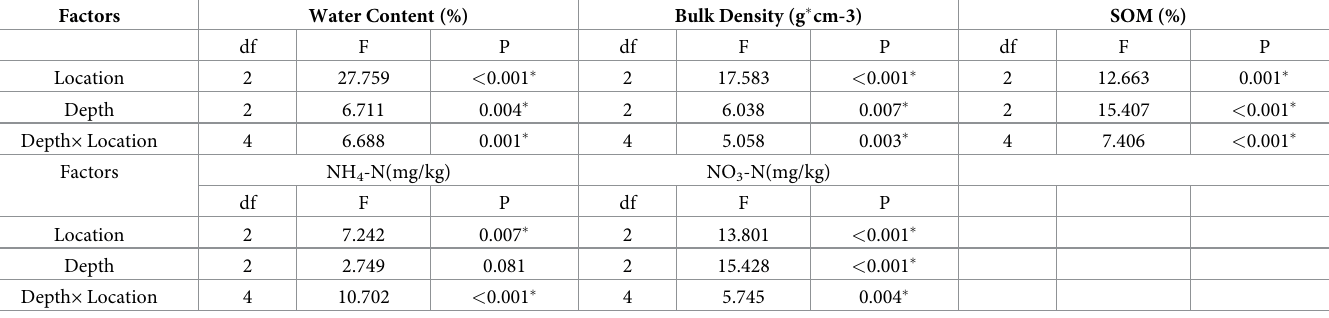
F and P values based on repeated-measure ANOVA are given. The asterisk ( (cid:3) ) means significant difference at P < 0.05